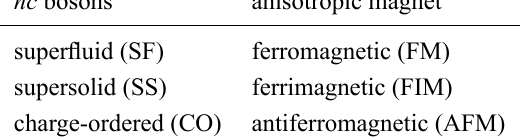
Table 1. The corresponding phases of hc bosons and anisotropic